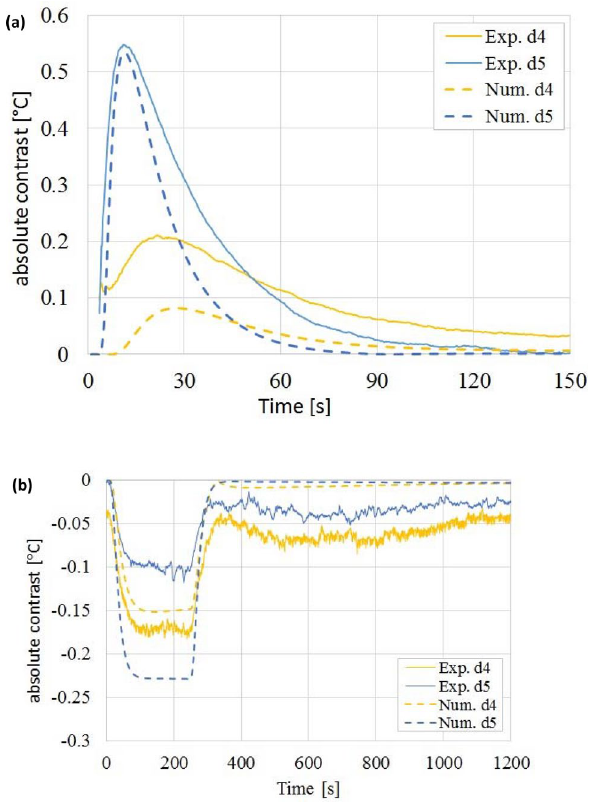
Fig. 10 Comparison of experimental and numerical evaluation of absolute contrast: a traditional thermography with heating time of 3 s; b SMArt thermography with heating time of 240 s